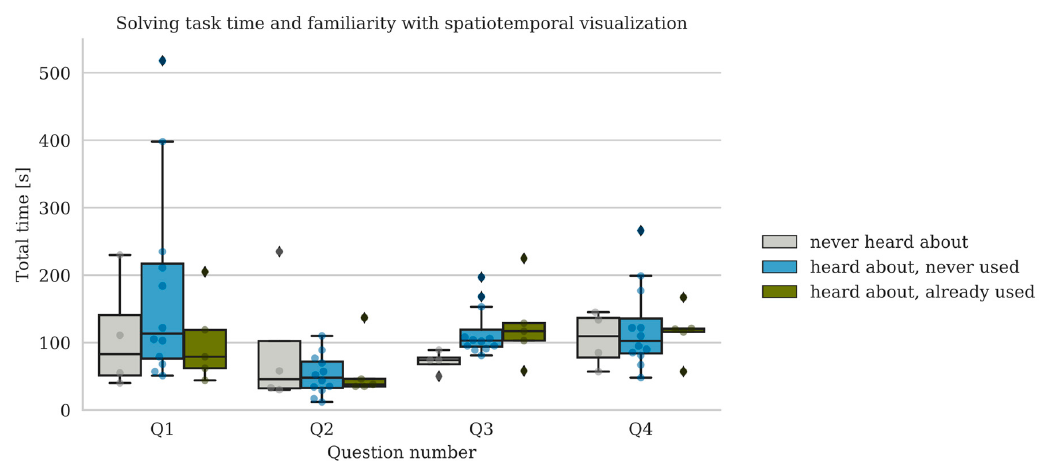
Figure 11. Solving task time grouped by questions and users’ familiarity with spatiotemporal visualization techniques.